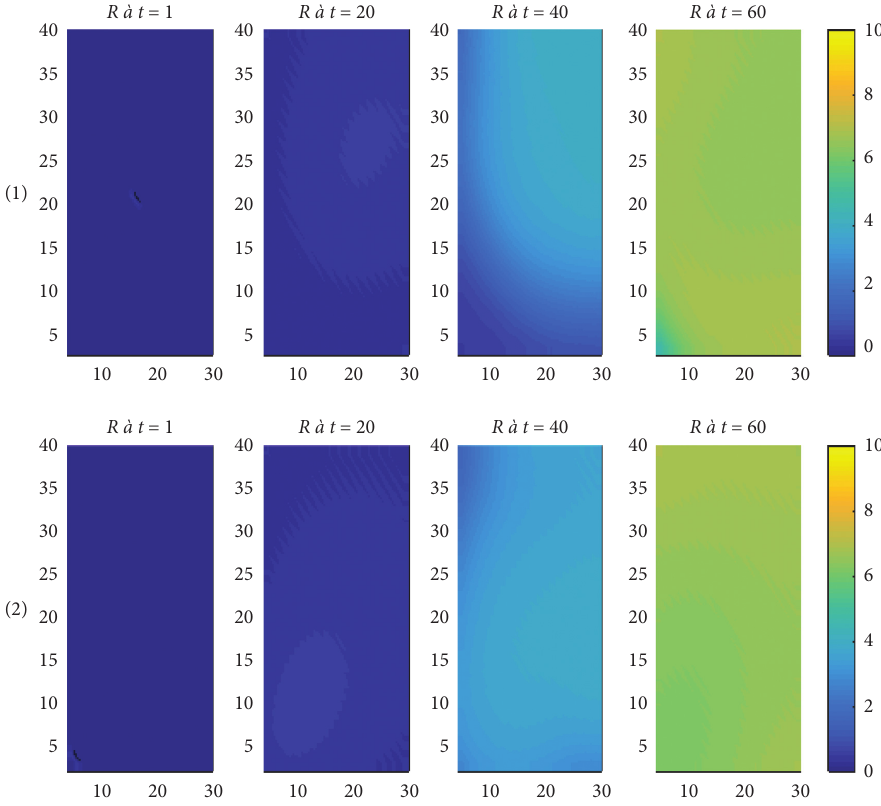
Figure 10: Recovered behavior within Ω with control (vaccine strategy starts from the first